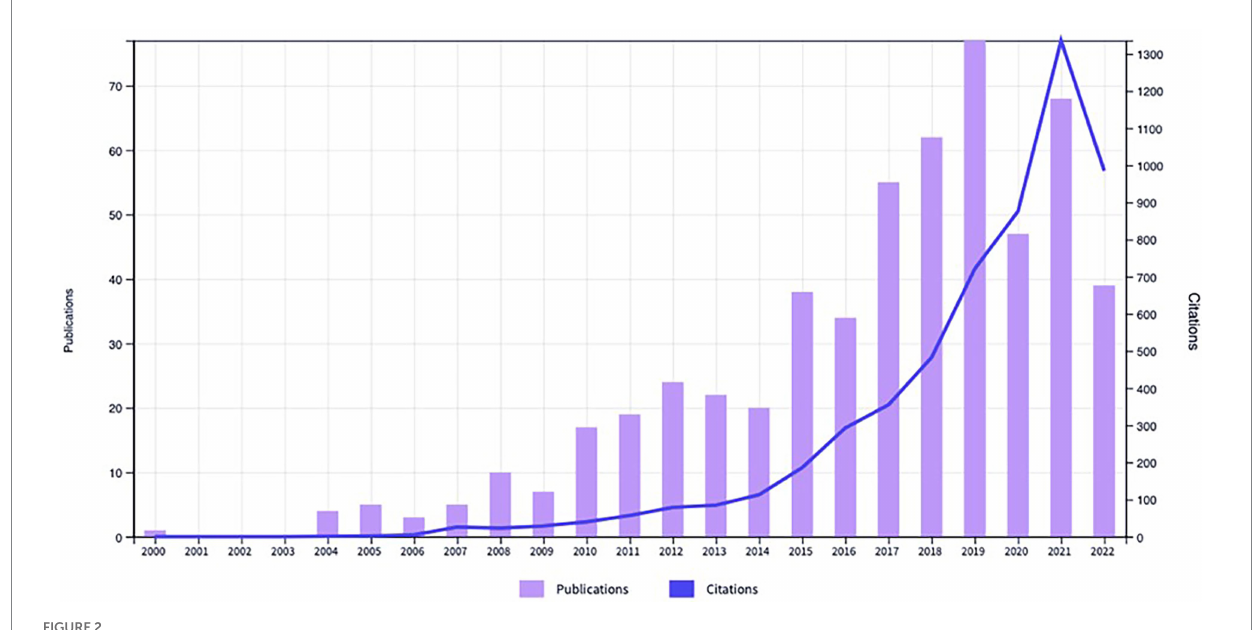
FIGURE 2 Search analysis summary on helix model and education in